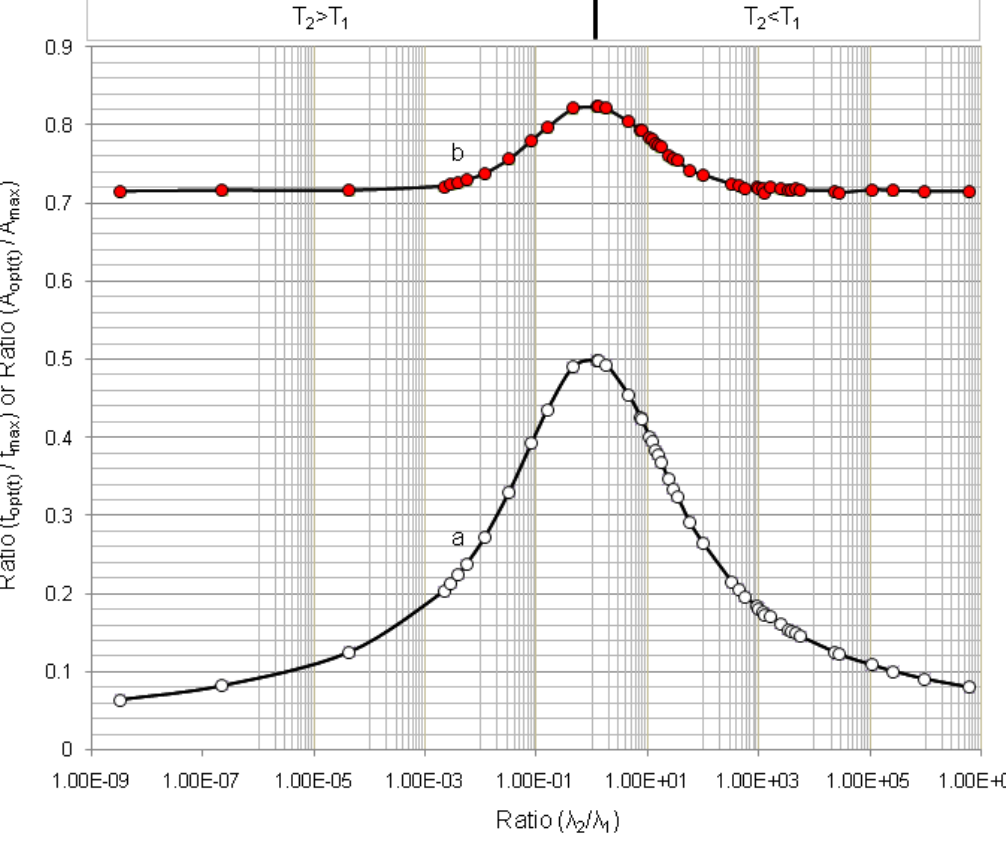
and radioactivity value A of daughter opt ( t ) 2, opt ( t ) and A , respectively, in function of decay constant max 2,max / t ); (b) Ratio ( A / A ); T and T are the half-life times opt ( t ) max 2, opt ( t ) 2,max 1 2